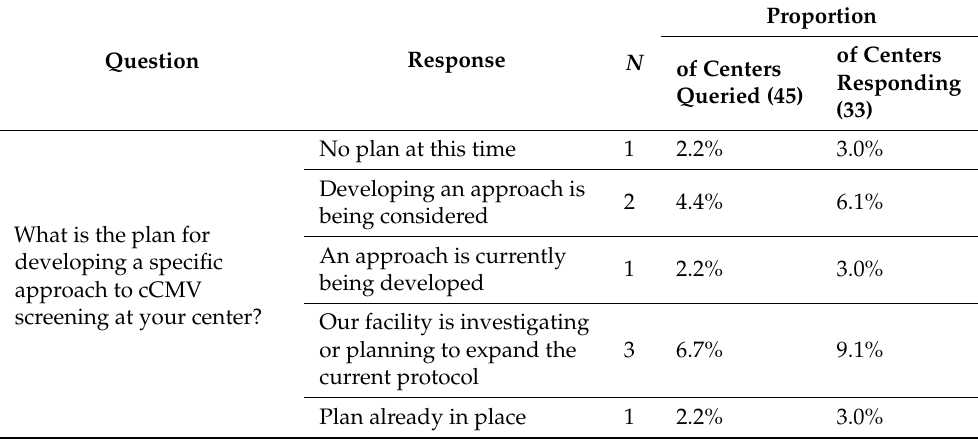
Table 7. Responses regarding plans for a specific approach to cCMV